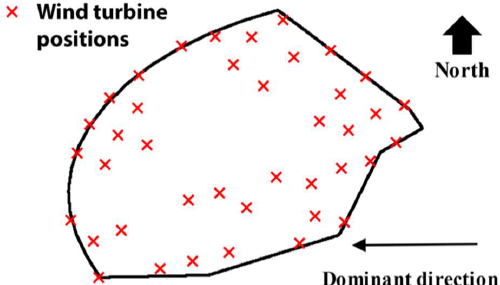
Figure 5. Optimal wind farm layout with 40 wind turbines under constant wind speed and constant wind direction.